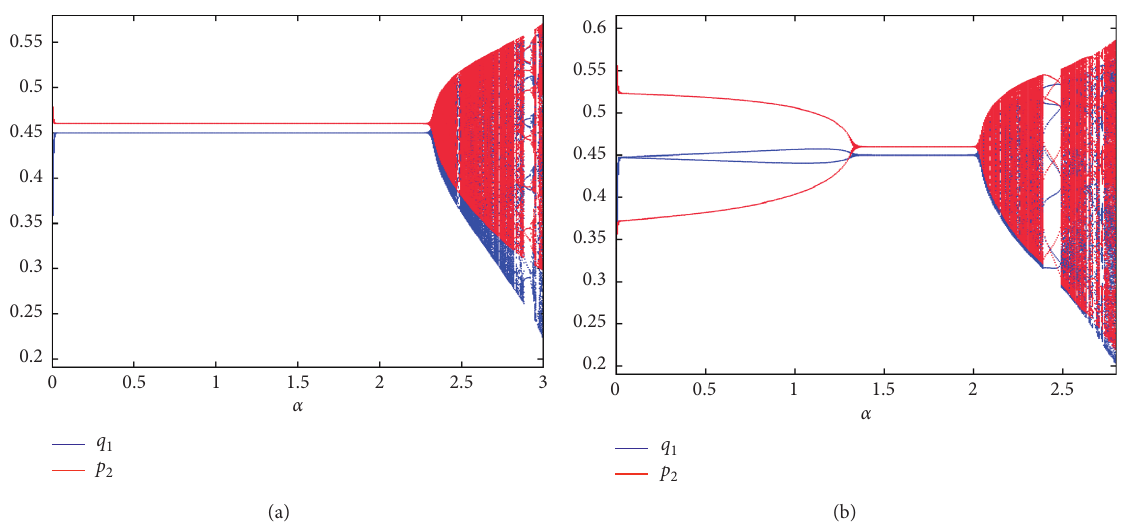
Figure 5: Bifurcation diagram of the dynamic system (12) with respect to α : (a) β � 2 and (b) β � 2 . 3.